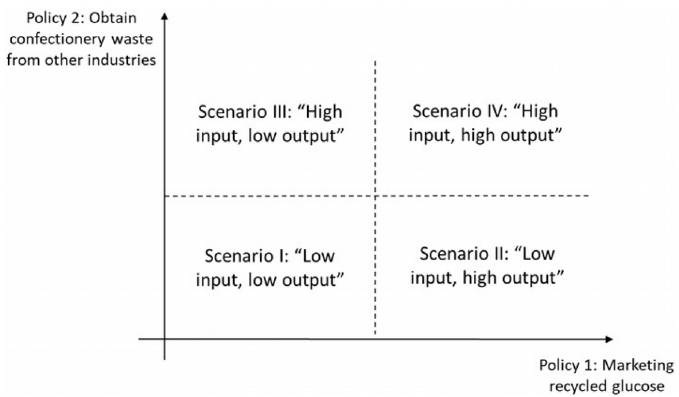
Figure 6. Four scenarios proposed from two